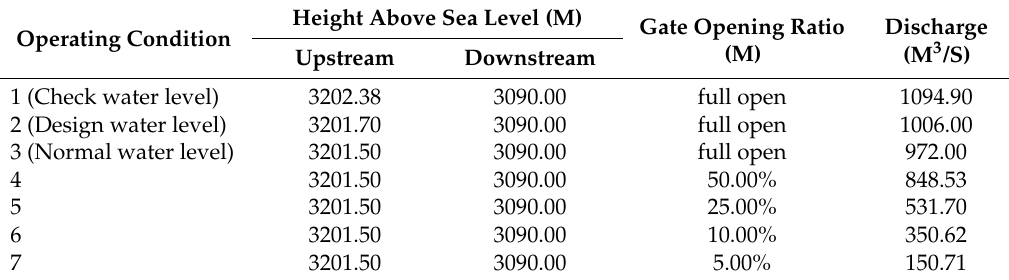
Table 1. Prototypical discharge